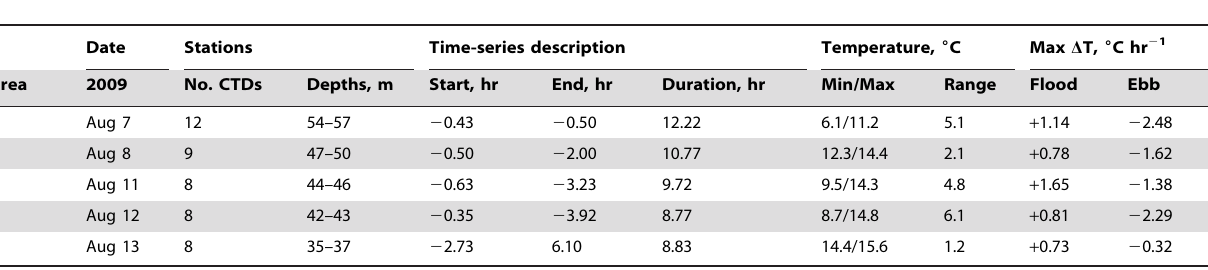
Table 3. Rates of seabed temperature change at time-series sites in study areas